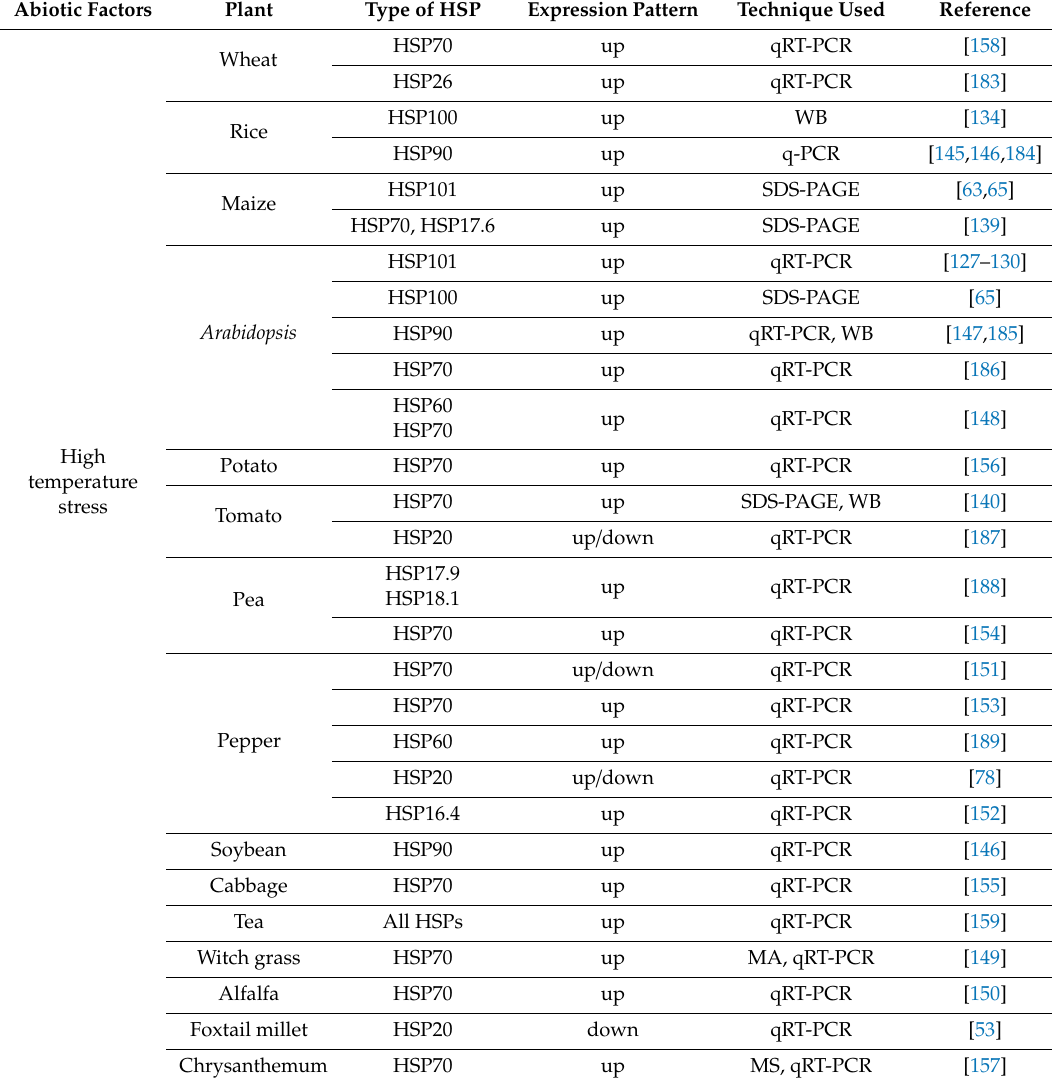
Table 3. Summary of studies of plant HSP and abiotic